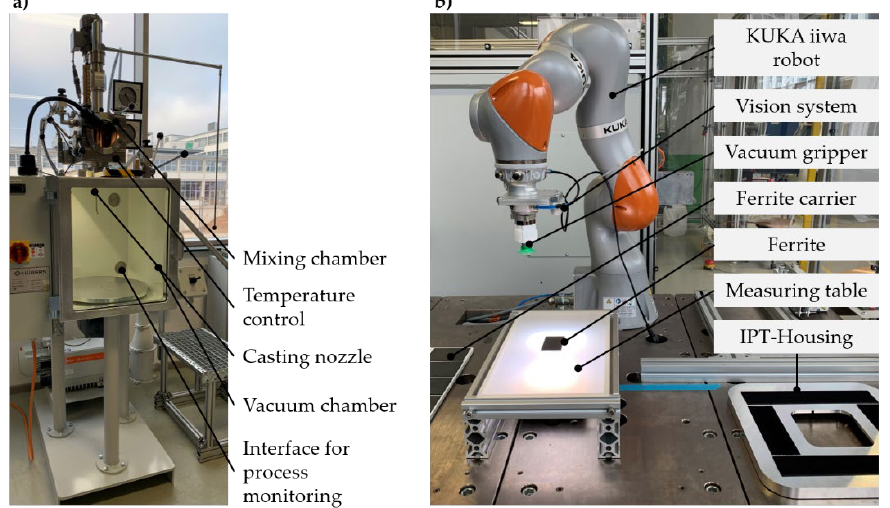
Figure 6. Vacuum potting machine ( a ), robot-based ferrite structure assembly ( b ).